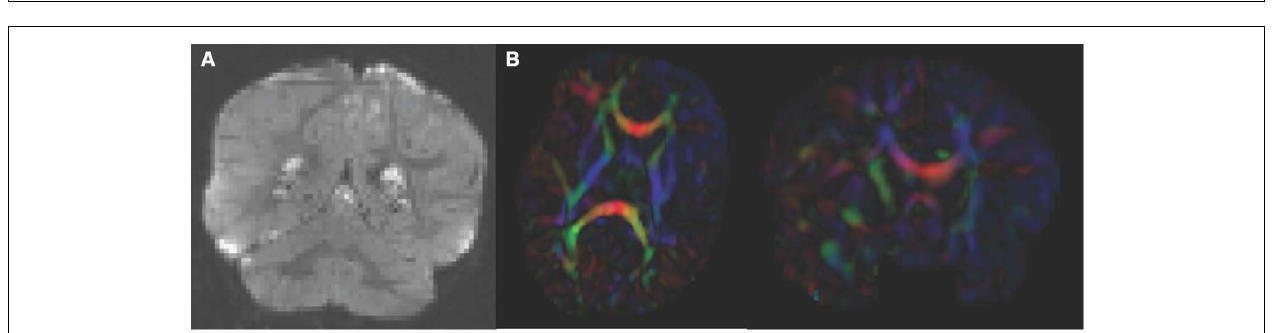
From these fiber bundles, diffusion parameter profiles are extracted and analyzed along with other study variables to determine significant interactions.